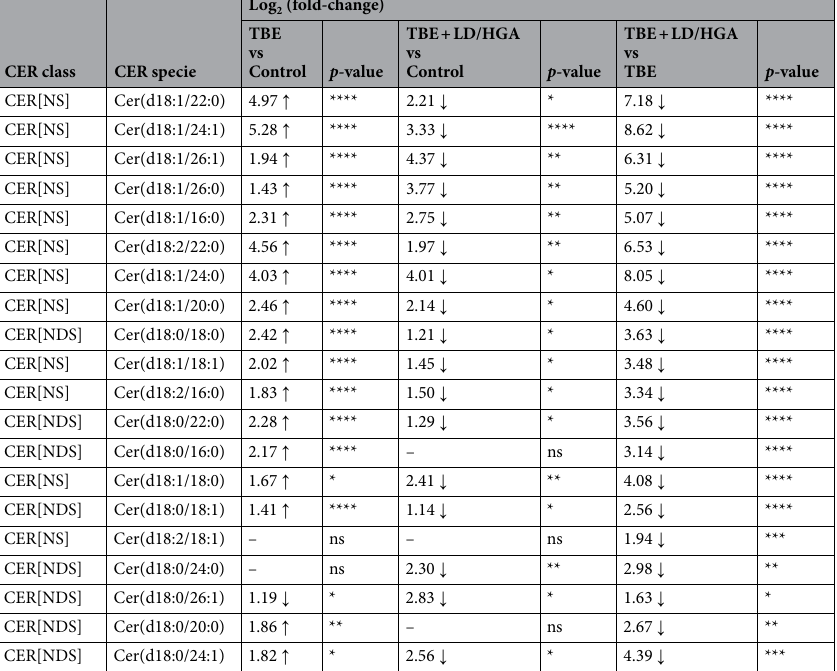
Table 4. The alterations observed in the 20 most discriminating (according to the one-way ANOVA) CER species (CER[NS], CER[NDS]) in the plasma of healthy subjects (Control) and TBE patients (TBE) and TBE patients with co-infections (TBE + LD/HGA). All the alterations are significant at the P < 0.05 level. (non- hydroxy fatty acid [N], α-hydroxy fatty acid [A], dihydrosphingosine [DS], sphingosine [S]); mean difference was significant at the 0.05 level (p < 0.0001****; p < 0.001***; p < 0.01**; p < 0.05*; n.s. – not significant; the up arrows represent up-regulation and down arrows represent down-regulation.